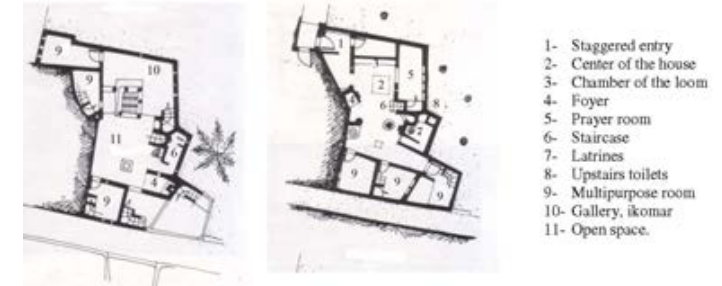
Figure 5. Traditional Mozabite house (Ravereau, Fathy & Roche, 1981)